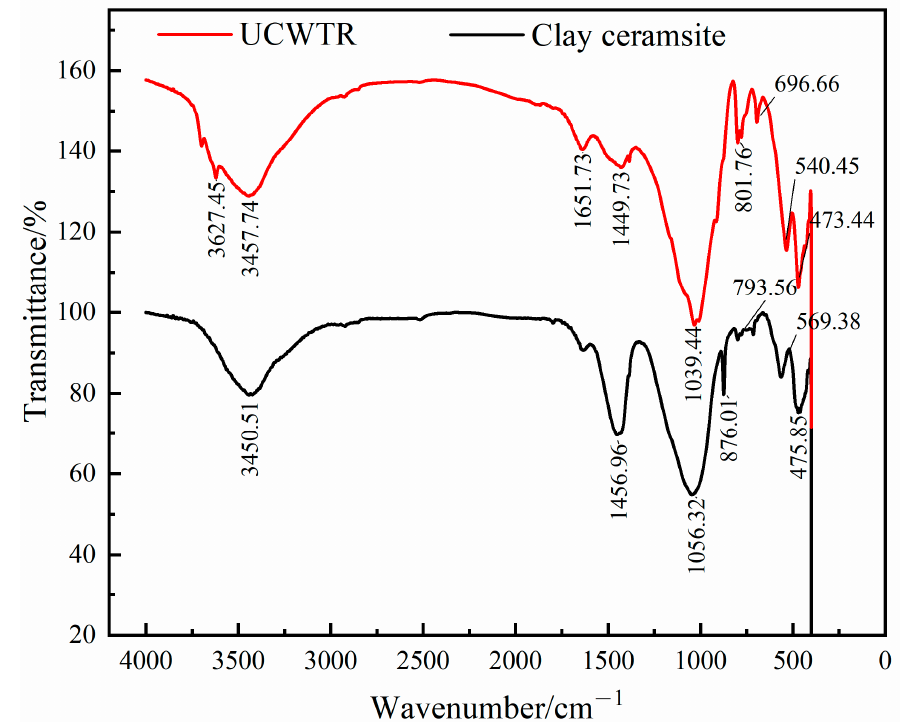
Figure 6. FT-IR of CWs UCWTR and clay ceramsite.